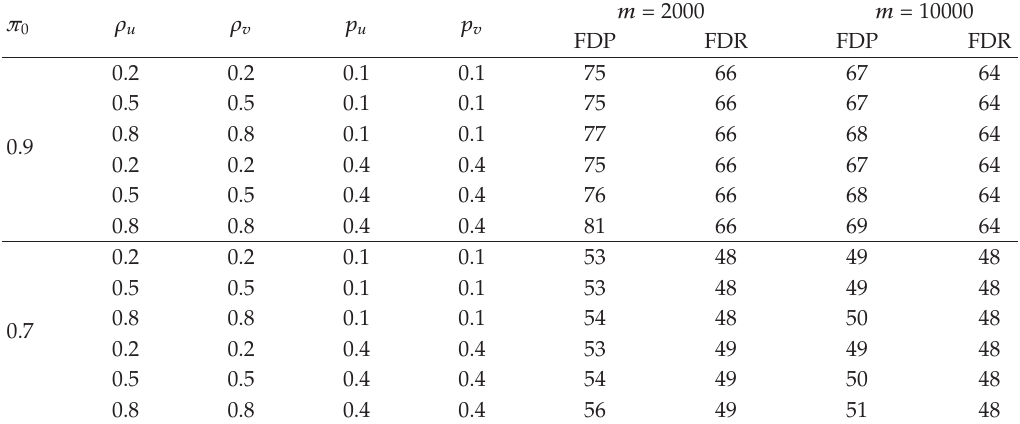
Table 3: Sample size calculation for controlling FDP and FDR to achieve overall power, autoregressive correlation structure.